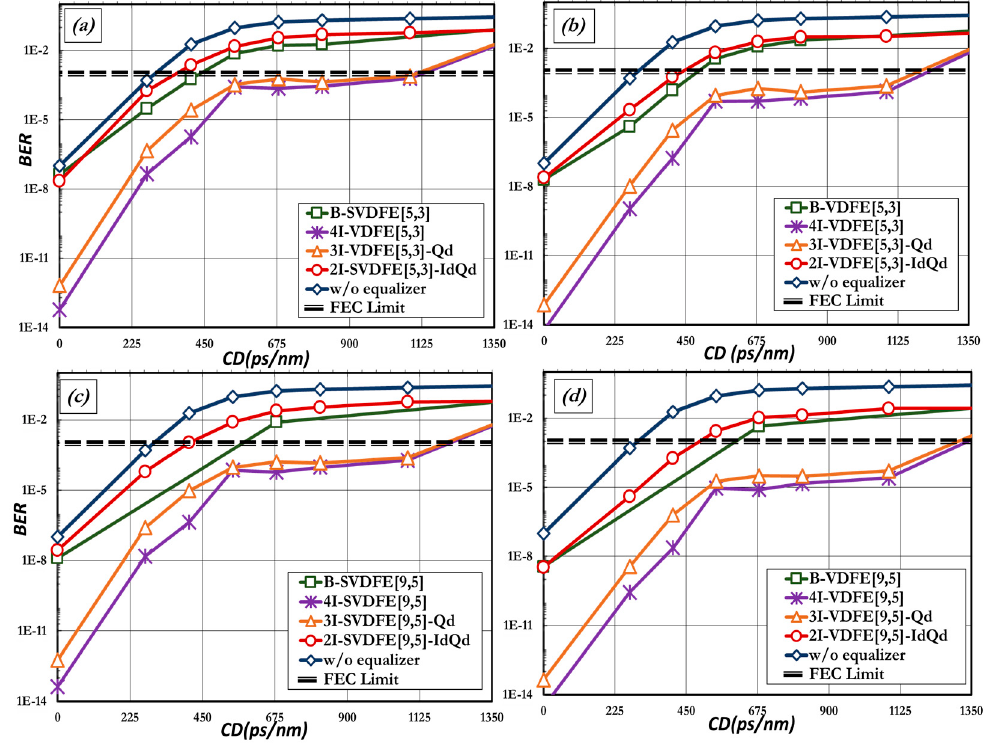
Figure 10. Estimated BER of optical links that utilize ( a ) SVDFE[5,3]; ( b ) VDFE[5,3]; ( c ) SVDFE[9,5] and ( d ) VDFE[9,5] for 2I-, 3I, and balanced equalization.